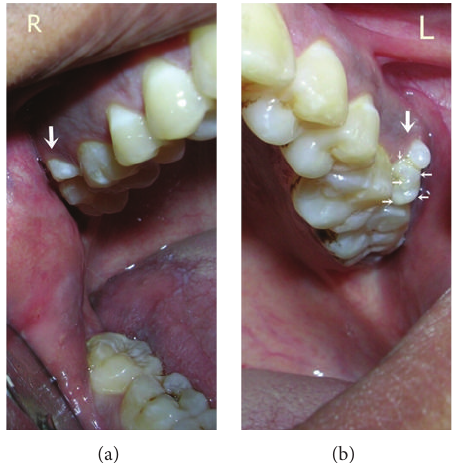
Figure 1: Showing the bilateral paramolars on right and left (multilobed) sides in case-1.